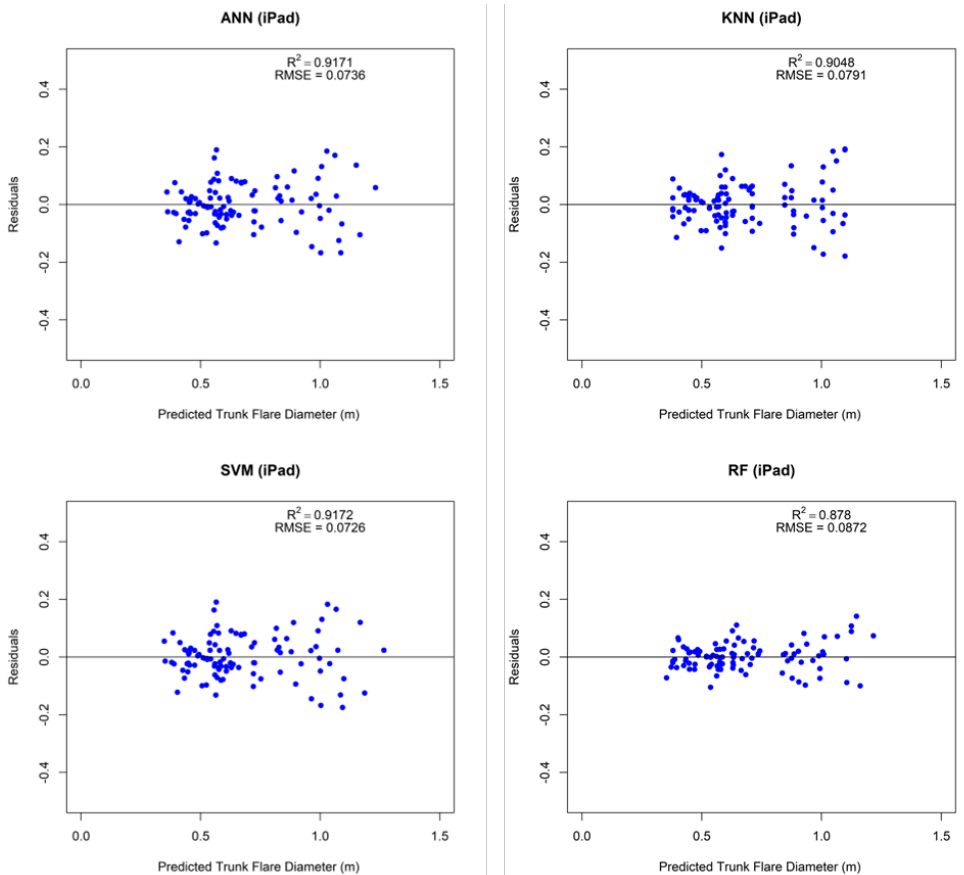
Figure 9. Residual distribution according to the predicted trunk flare diameter from four different algorithms using iPad Pro data.